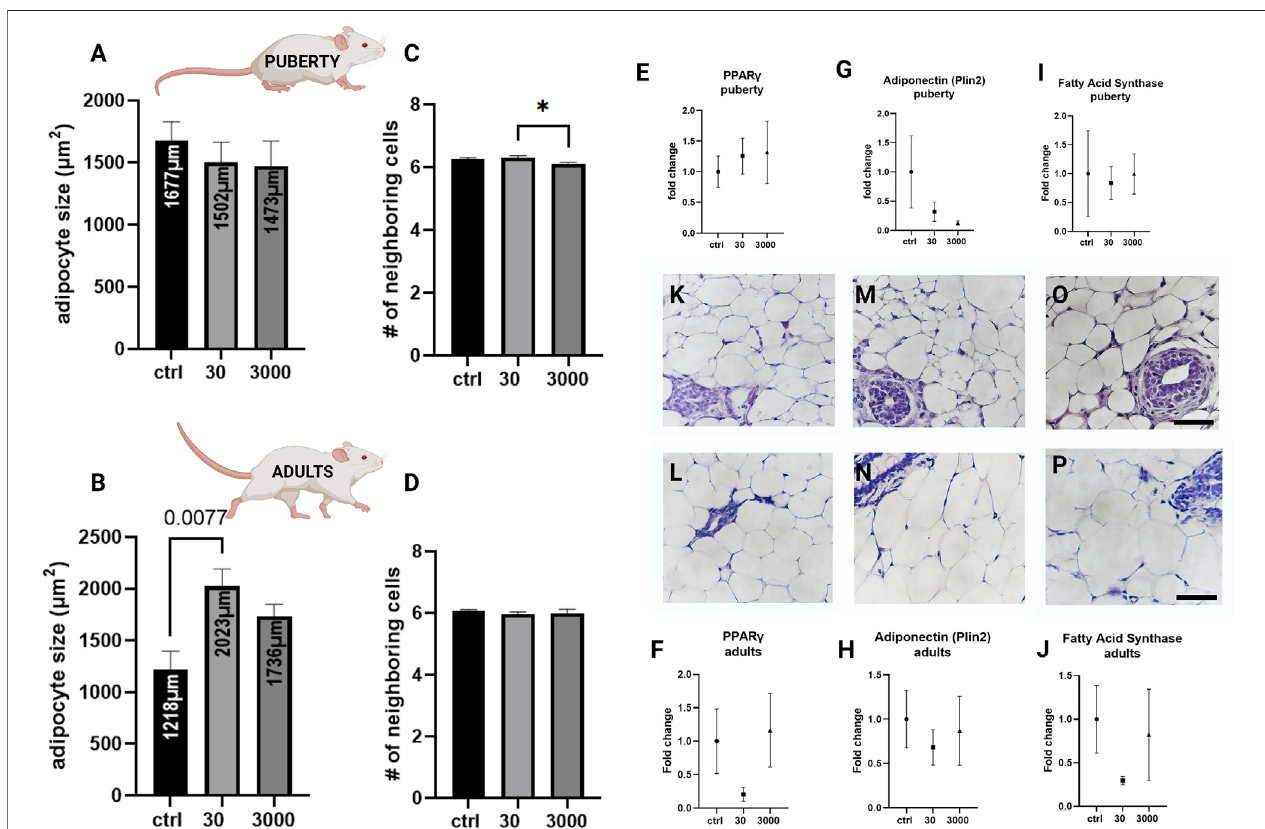
FIGURE 3 | Alterations to white adipose tissue in oxybenzone-treated females. (A) Average size of white adipocytes at puberty. (B) Average size of white adipocytes in adulthood. (C) Number of adipocyte-adjacent cells at puberty. (D) Number of adipocyte-adjacent cells in adulthood. (E) Relative mRNA expression of PPAR γ mRNA at puberty (F) Relative mRNA expression of PPAR γ mRNA in adulthood. (G) Relative mRNA expression of Plin2 mRNA at puberty. (H) Relative mRNA expression of Plin2 mRNA in adulthood (I) Relative mRNA expression of Fas mRNA at puberty (J) Relative mRNA expression of Fas mRNA in adulthood; (K,M,O) Representative images of adipose tissue in pubertal animals in controls (K) and treatment groups of 30 (M) and 3000 μ g/kg/day (O) . (L,N,P) Representative images of adipose tissue in adult animals in controls (L), 30 (N), and 3000 μ g/kg/day (P) . Scale bar = 20 µm in each image.* indicates signi fi cance < 0.05: ANOVA, Tukey posthoc test. All qRT-PCR expression data were normalized using the ΔΔ Ct